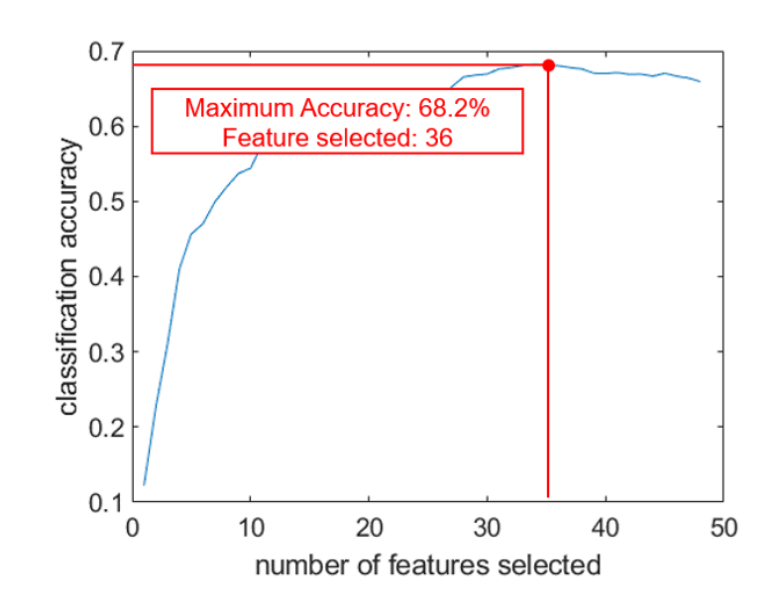
Figure 17. Feature selection results with the combination of 3 feature types.